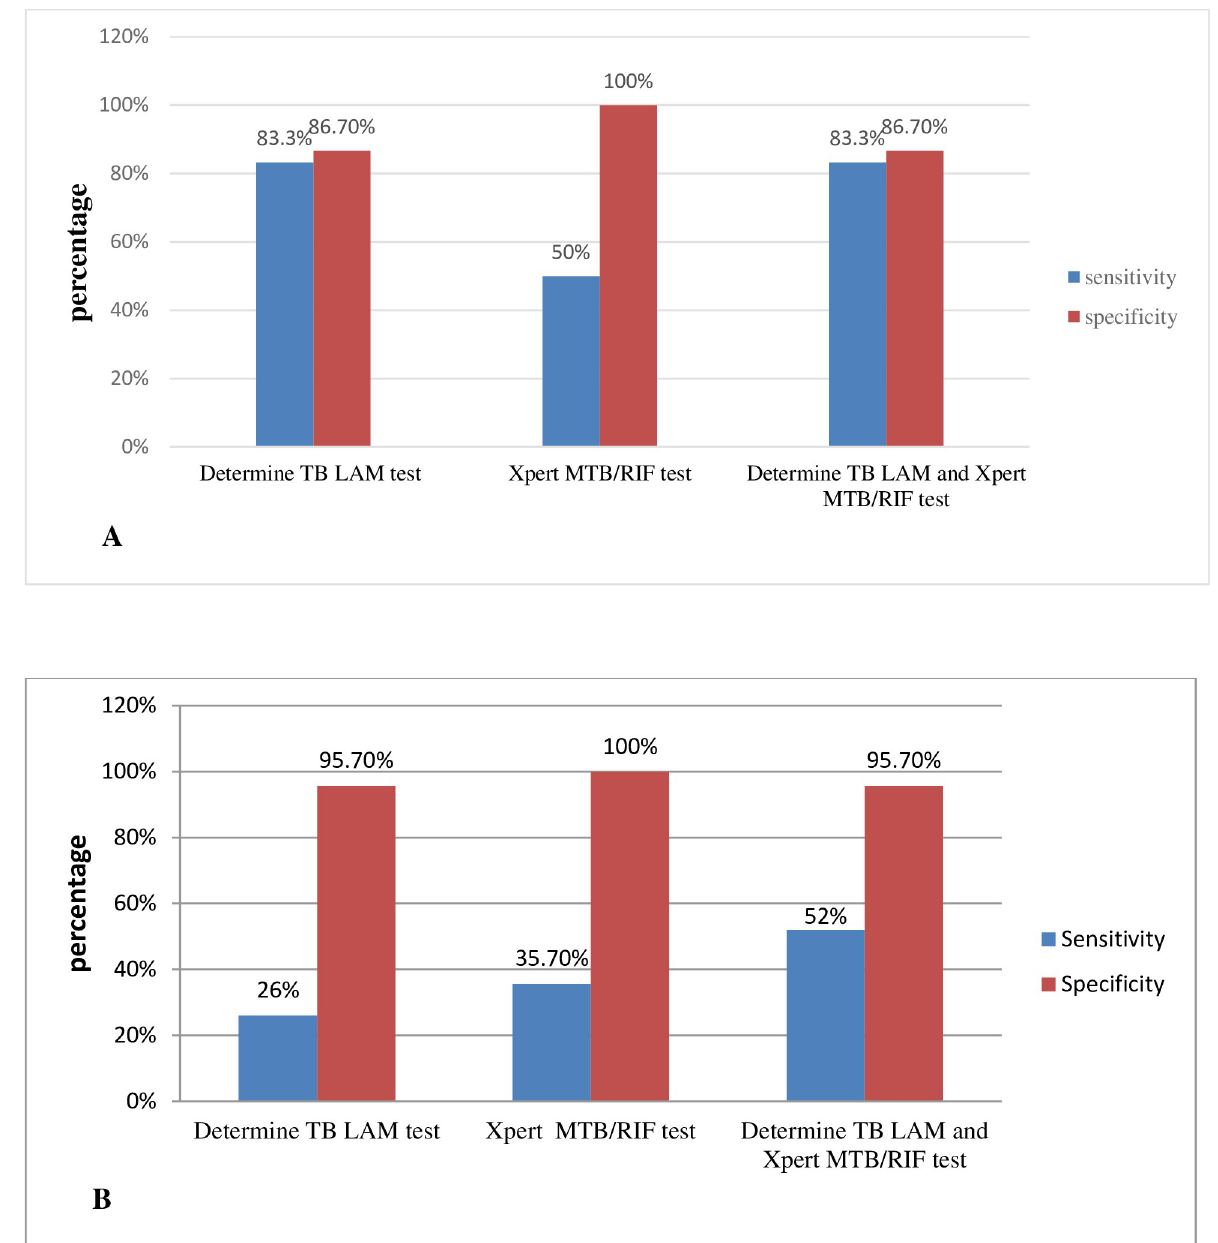
Fig 2. Performances of TB-LAM, Xpert MTB/RIF and combination of TB-LAM and Xpert MTB/RIF tests comparing to CRS among HIV positive (A) and HIV negative (B) cases.